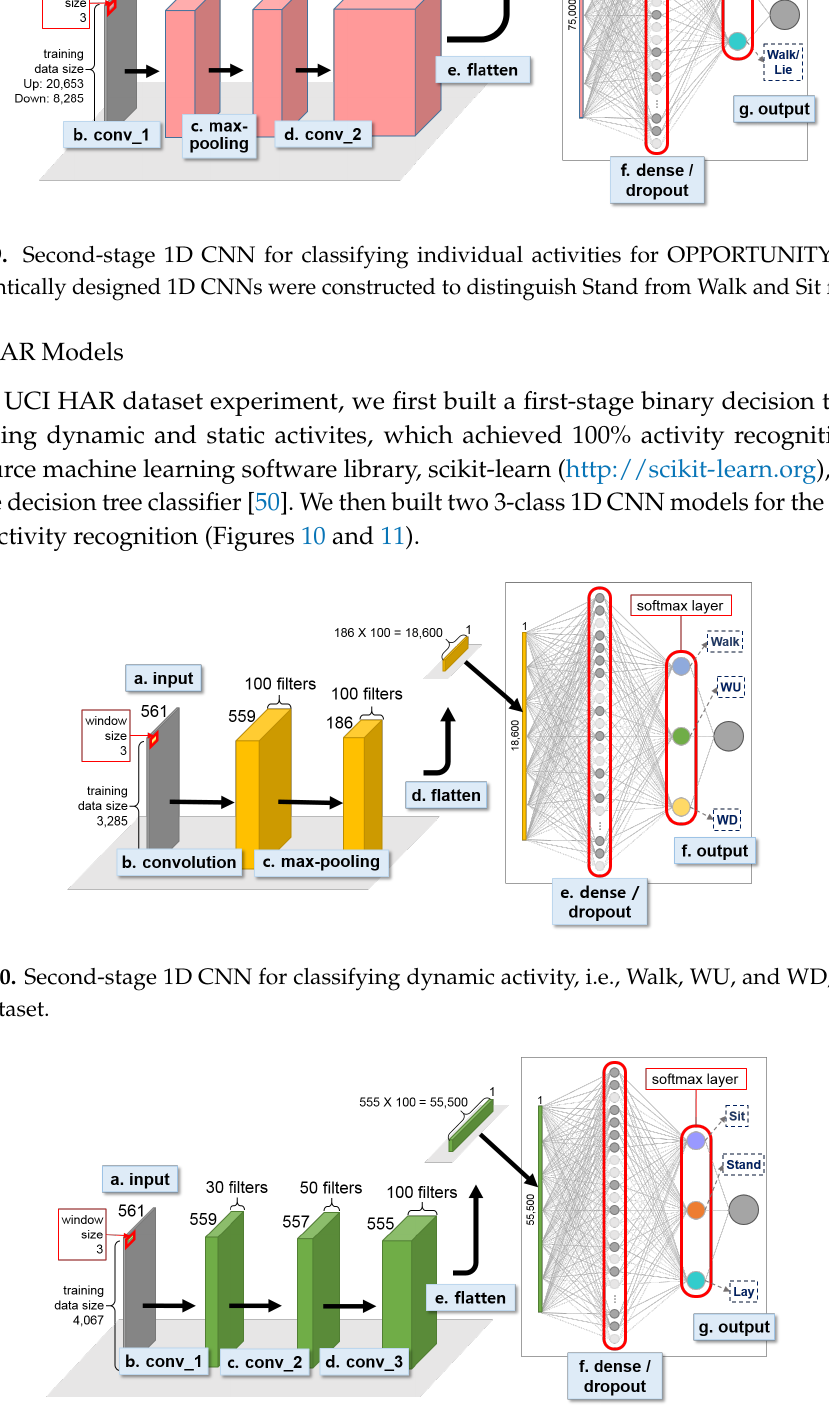
Figure 11. Second-stage 1D CNN for classifying static acitivity, i.e., Sit, Stand, and Lay, for UCI HAR